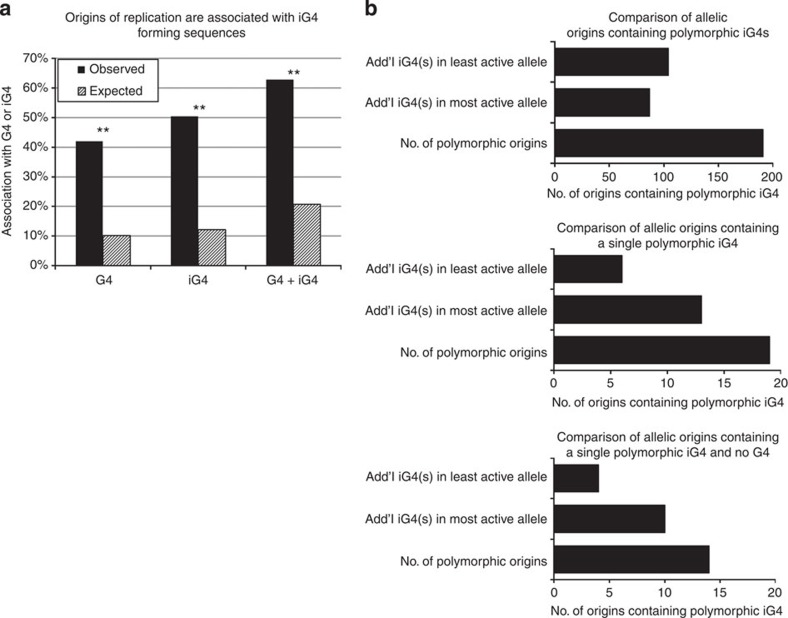
Intermolecular iG4s are highly enriched in origins of replication but their presence does not correlate with origin usage.(a) Origins of replication contain more iG4s than expected by chance. Bar plot illustrating the association between G4s, iG4s and origins of replication. y axis, per cent of origins associated with G4s, iG4s or both. Black bars: observed association, striped bars: association expected by chance (10,000 permutations). Stars indicate that the differences between observed and expected values were significant (permutation P value <0.001). (b) Presence of iG4s does not correlate with origin activity. Top plot: x axis, number of origins containing one or more polymorphic iG4. Middle plot: same as above but restricted to origins containing at most 1 iG4. Bottom plot: same but restricted to origins containing no G4s and at most one iG4.